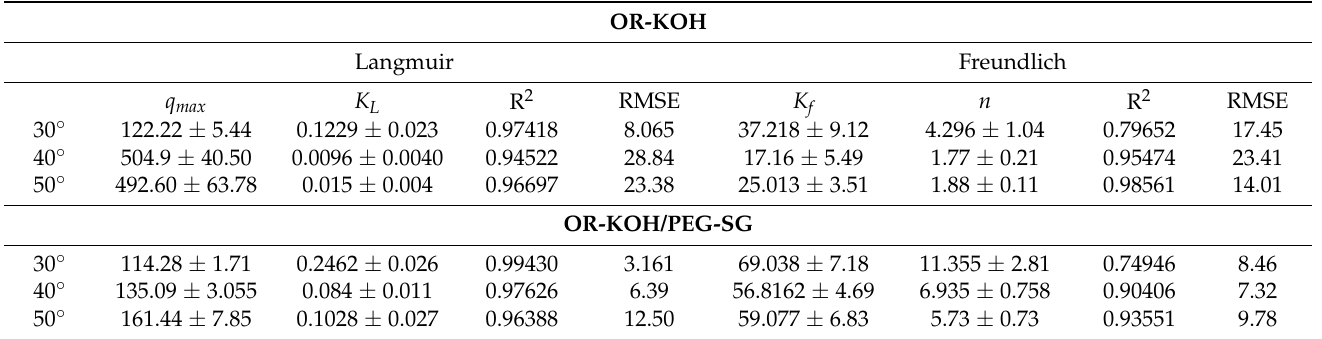
Table 1. Langmuir and Freundlich parameters for MB adsorption onto bioadsorbent. OR-KOH Langmuir